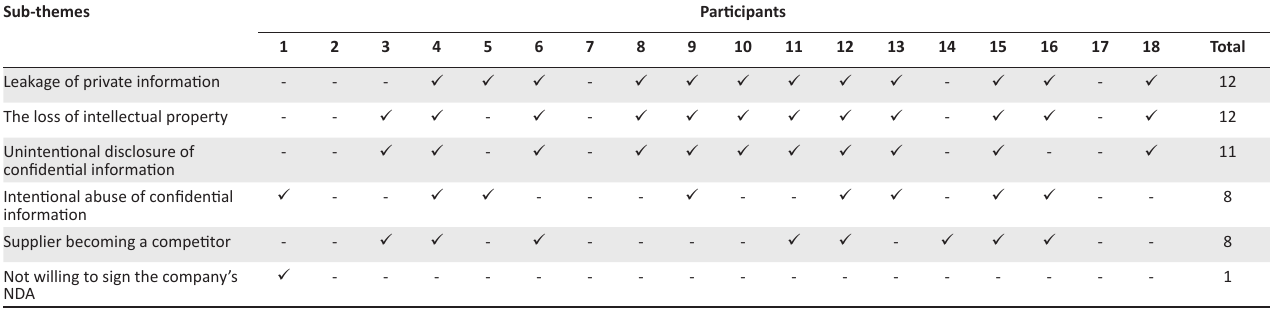
TABLE 5: Frequency of security risks associated with risk information sharing.